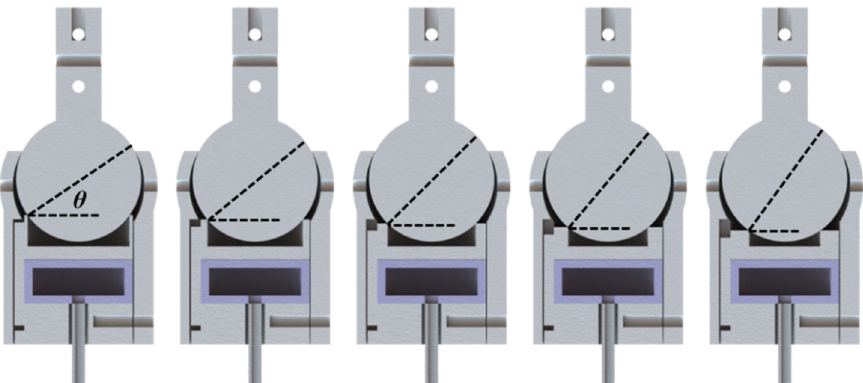
Figure 5. Five support platform designs with increasing intersection angles ( θ ) assembled with the ball joint structure (Sectional view).